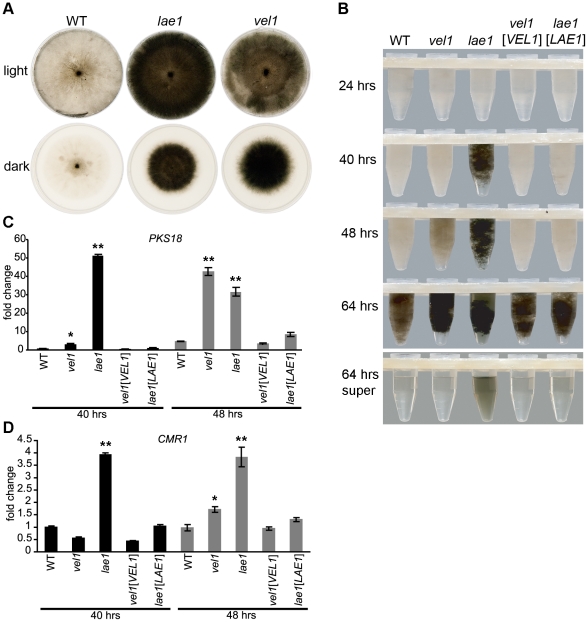
Lae1 and Vel1 proteins negatively regulate mycelial pigmentation of C. heterostrophus.
A. Bottom of culture plates incubated in constant light or dark for 9 days. Pictures were taken after removal of conidia. Note heavy pigmentation of mycelia of Chlae1 and Chvel1 mutants in both light and dark compared to WT. B. Mycelial pellet of WT strain C4, Chvel1, Chlae1 mutants, and complemented strains (vel1[VEL1], lae1[LAE1]) at different time points indicated. Supernatant is shown only for the 64 hour samples. Chlae1 strain is melanized by 40 hrs, clearly ahead of other strains. Melanization starts by 48 hrs in Chvel1, while pigmentation is not evident in WT at this time. The supernatant of the Chlae1 strain is pigmented indicating secretion of pigment(s) into the medium (no conidia are present). C. qPCR analyses of PKS18. Expression was examined for the samples from B at 40 and 48 hours. Expression level relative to the WT strain C4 sample at 40 hours is shown. Error bars represent range of fold change calculated according to standard deviation of ΔΔCt. Single asterisks indicate p-value <0.05, double asterisks indicate p-value <0.001 in T-test analysis in which each strain was compared with corresponding WT C4 at the same time point. Matching the enhanced pigmentation (B), PKS18 is induced in Chlae1 by 40 hrs and in Chvel1 by 48 hrs. D. qPCR analyses of CMR1. Expression was examined for the samples from B at 40 and 48 hours. Expression level relative to the WT, C4 sample at 40 hours is shown. Error bars and T-test analysis are same as C. Like the enhanced pigmentation in B, CMR1 expression increased 1.7 and 3.8 fold in Chvel1 and Chlae1 mutants, respectively, compared to WT by 48 hrs. Note scale is different from C.